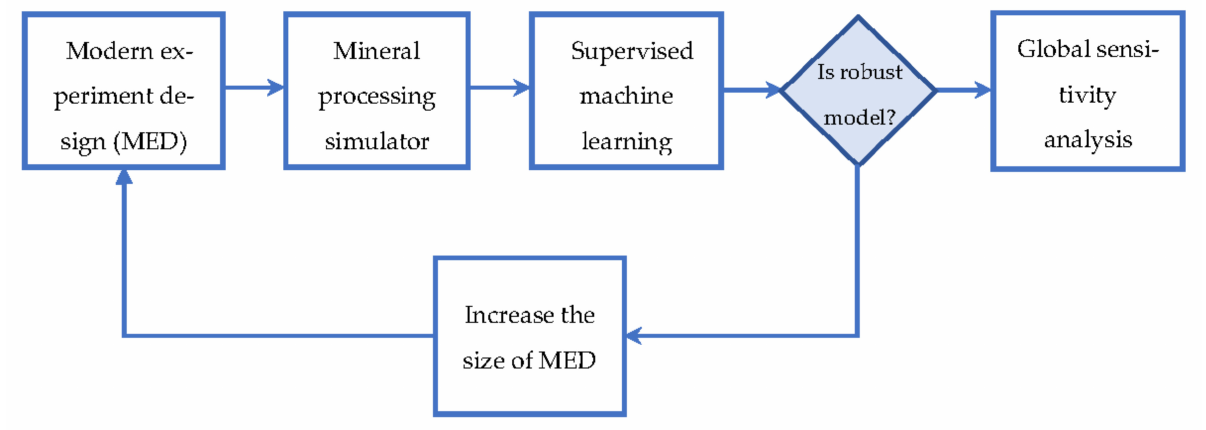
Figure 1. Flowchart for building SMs for accelerating